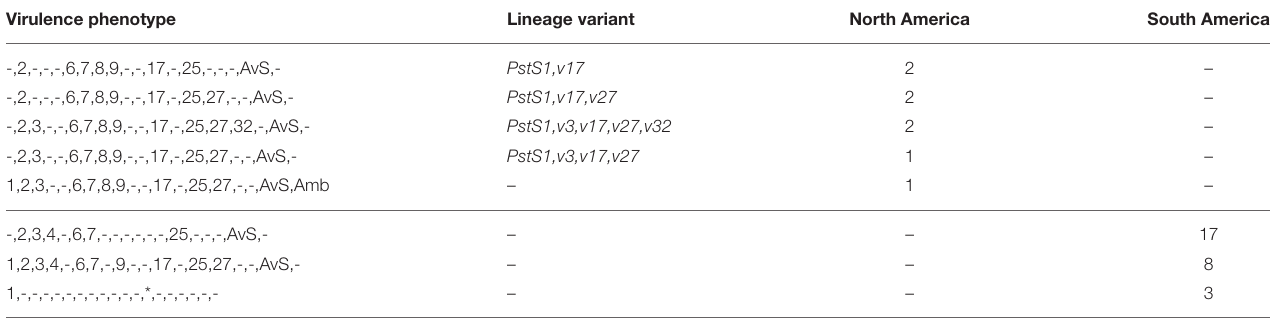
TABLE 4B | Prevalence of P. striiformis races detected in North America and South America during